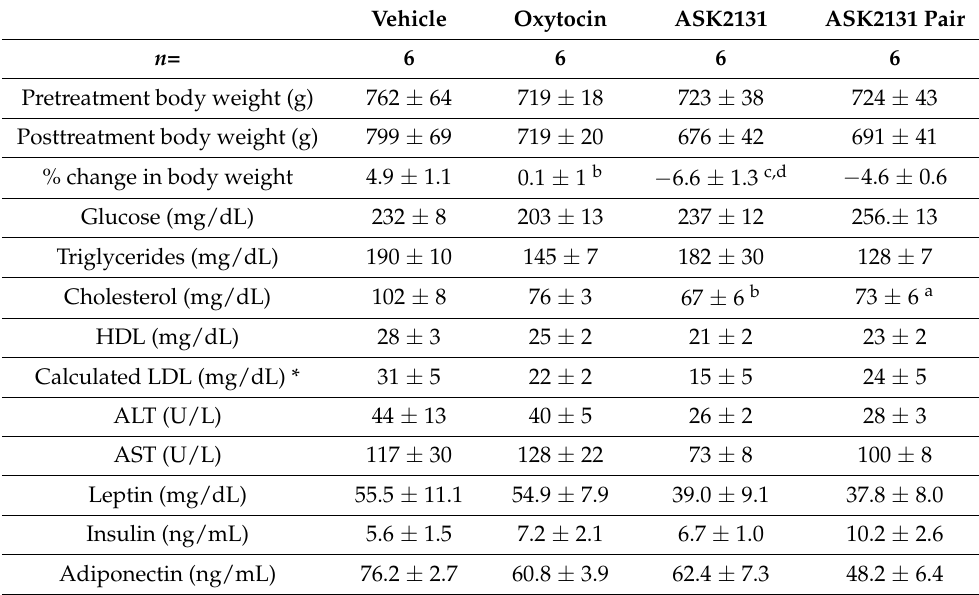
Table 3. Pre- and post-treatment body measures, and post treatment serum levels. Vehicle Oxytocin ASK2131 ASK2131